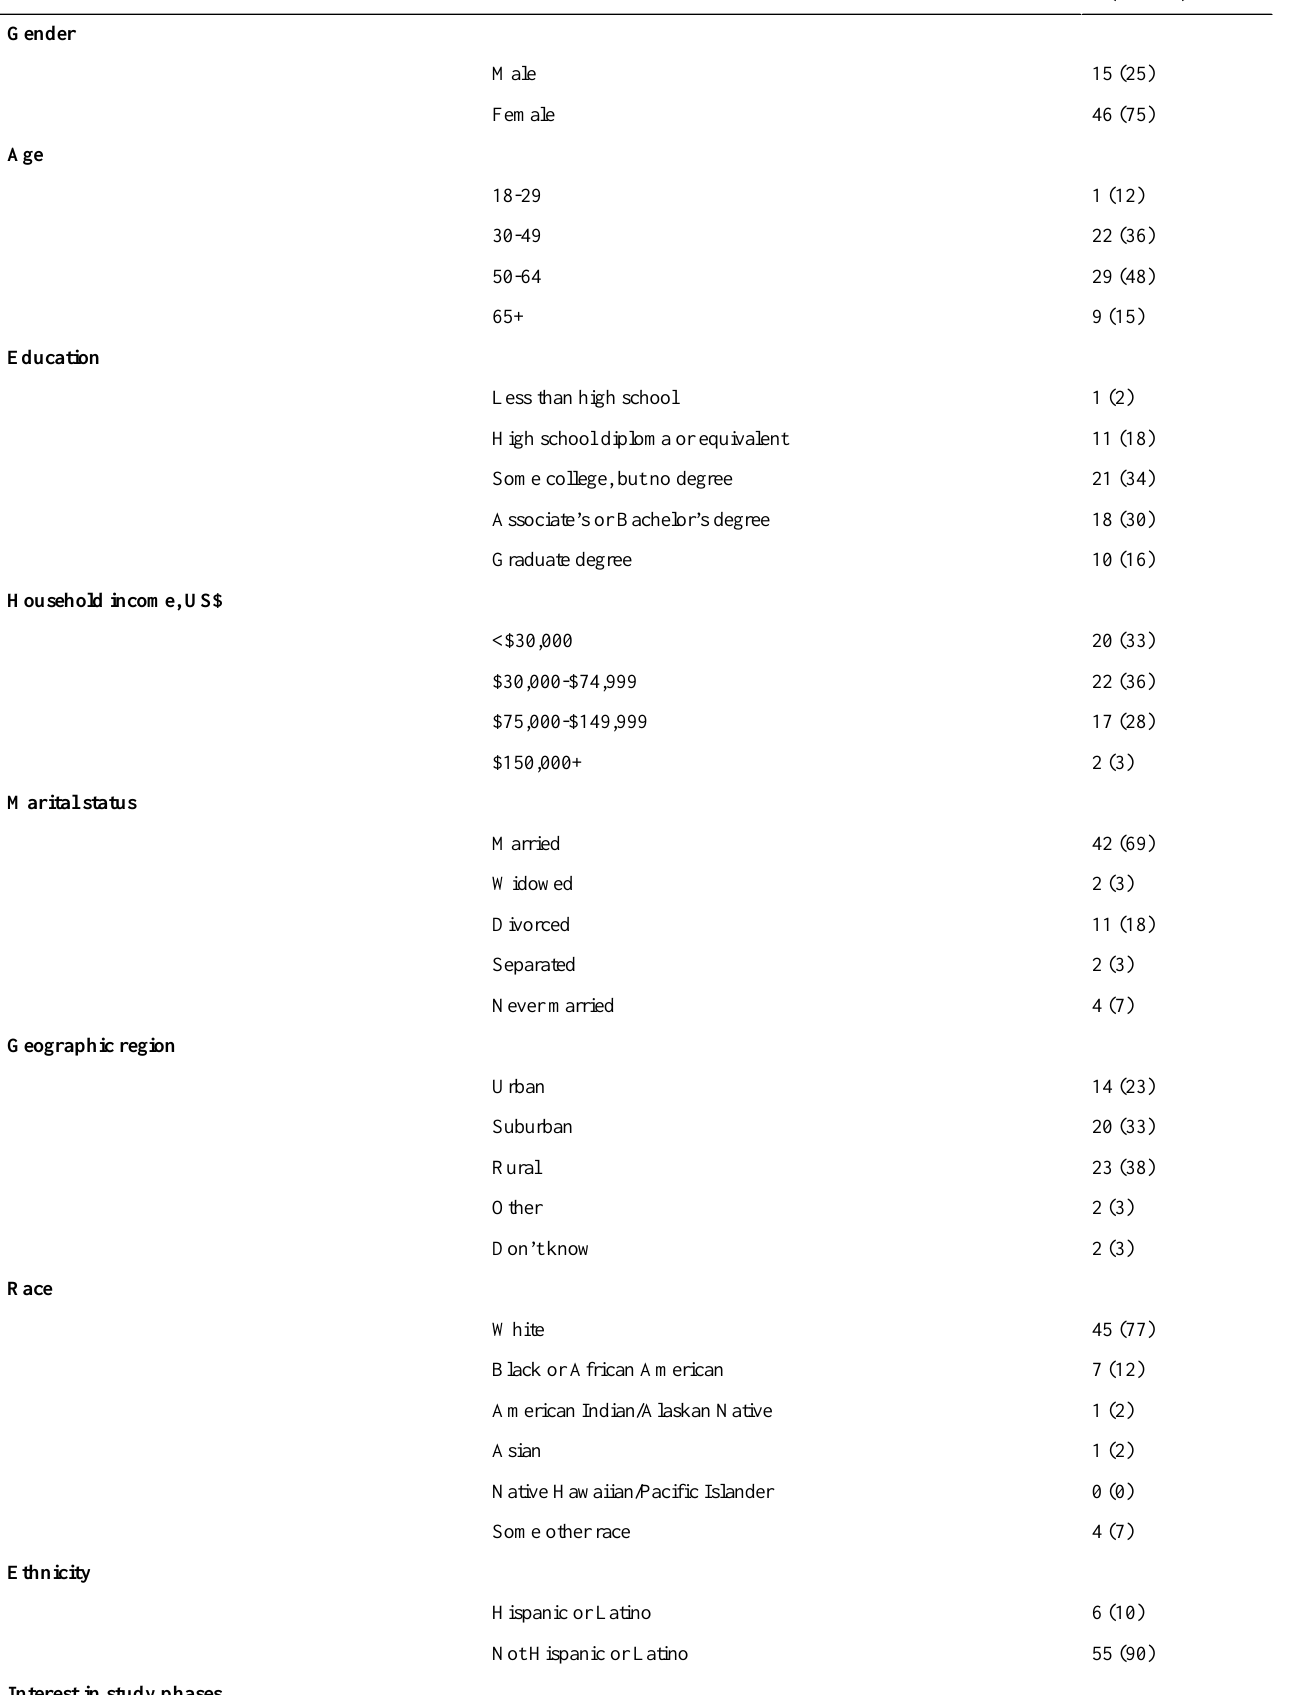
Table 3. Study 2 demographic characteristics (eligible only)